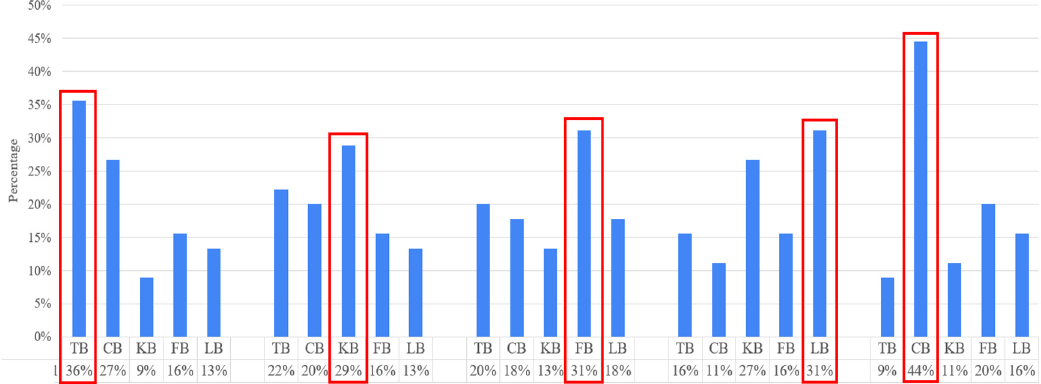
Figure 4. Ranking the foreseeable barriers of IPD in KSA.